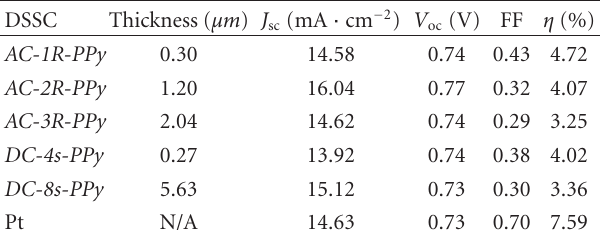
Table 1: Summary of polymer film thickness, open-circuit voltage ( V oc ), short-circuit current density ( J sc ), fill factor (FF), solar cell e ffi ciency ( η ) of the Pt and PPy